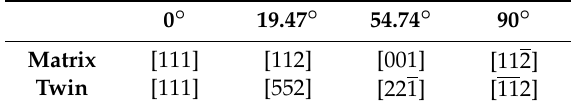
Figure 1. Cross-section view of the nanotwinned (NT) Au nanowires with ( a ) θ = 0°, ( b ) θ = 20°, ( c ) θ ( c ) θ = 54 ◦ , and ( d ) θ = 90 ◦ . The atoms are colored according to the common neighbor analysis (CNA). = 54°, and ( d ) θ = 90°. The atoms are colored according to the common neighbor analysis (CNA). The The blue, sky blue, and red atoms are FCC, HCP, and other atoms. blue, sky blue, and red atoms are FCC, HCP, and other atoms. Table 1. The lattice orientations of load axis for the specific twin Table 1. The lattice orientations of load axis for the specific twin orientation.